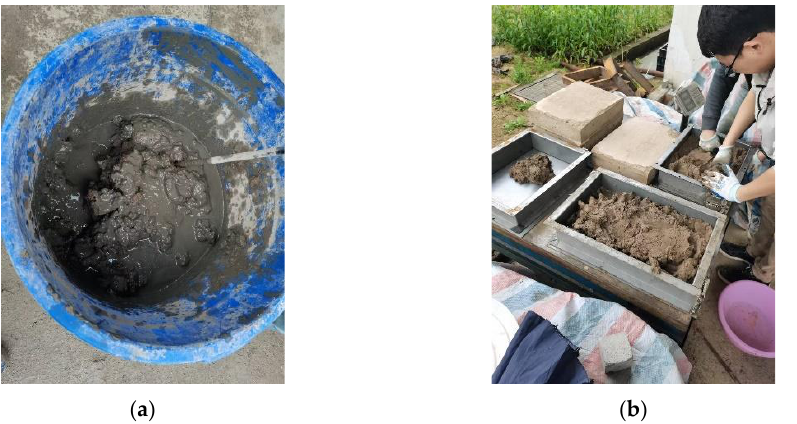
Figure 2. Preparation of the cement soil sample : ( a ) Cement soil mixing and ( b ) Cement soil formwork curing.